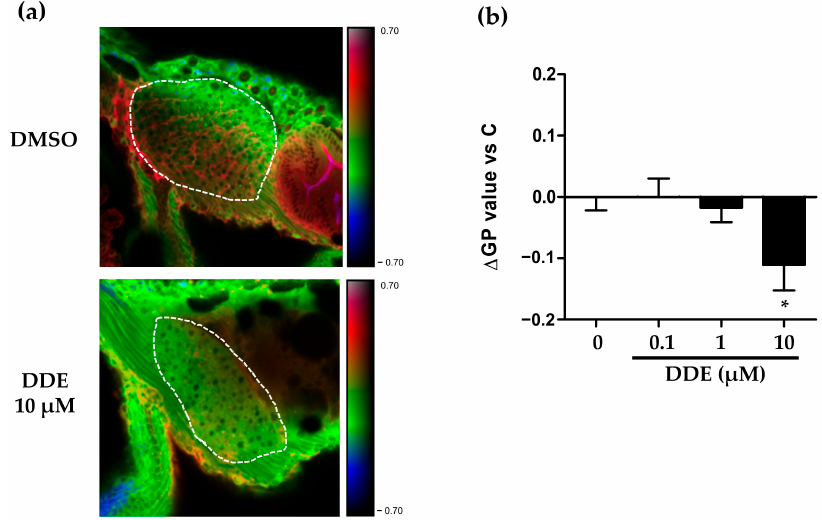
Figure 8. DDE exposure-induced membrane remodeling in the liver of zebrafish larvae. Membrane order characteristic of membrane remodeling was assessed in liver of zebrafish larvae at 3 dpf after exposure for 48 h to DDE (0.1/1/10 µM) or to control vehicle. Zebrafish larvae were stained with di-4-ANEPPDHQ—a membrane order-sensitive fluorescent probe—and analyzed by confocal fluores- cence microscopy. Membrane order in membranes of zebrafish liver was measured by computing the generalized polarization (GP) factor. ( a ) Representative liver images of control vehicle (DMSO) and DDE (10 µM) treatment (magnification ×400). The liver is delimited by the dotted lines. ( b ) Changes in GP values ( Δ GP) were expressed as the difference between individual larva GP value and the mean GP calculated in control larvae (DMSO). Values are the mean ± standard error of the mean (SEM) of at least 20 larvae. * p < 0.05 by comparison with the control group using ANOVA and Dunnett’s test.